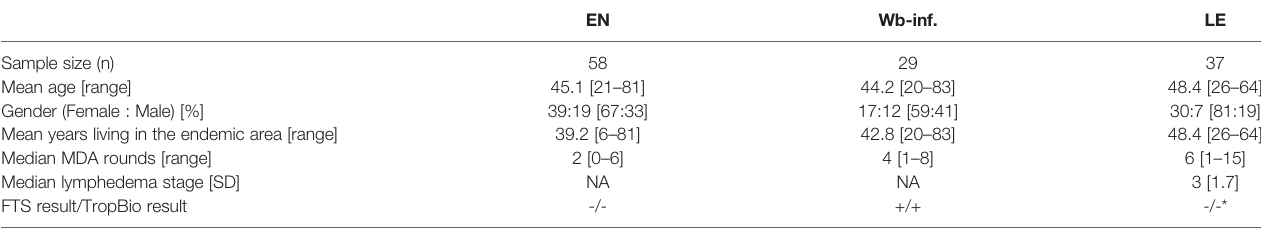
TABLE 1 | Study population characteristics.